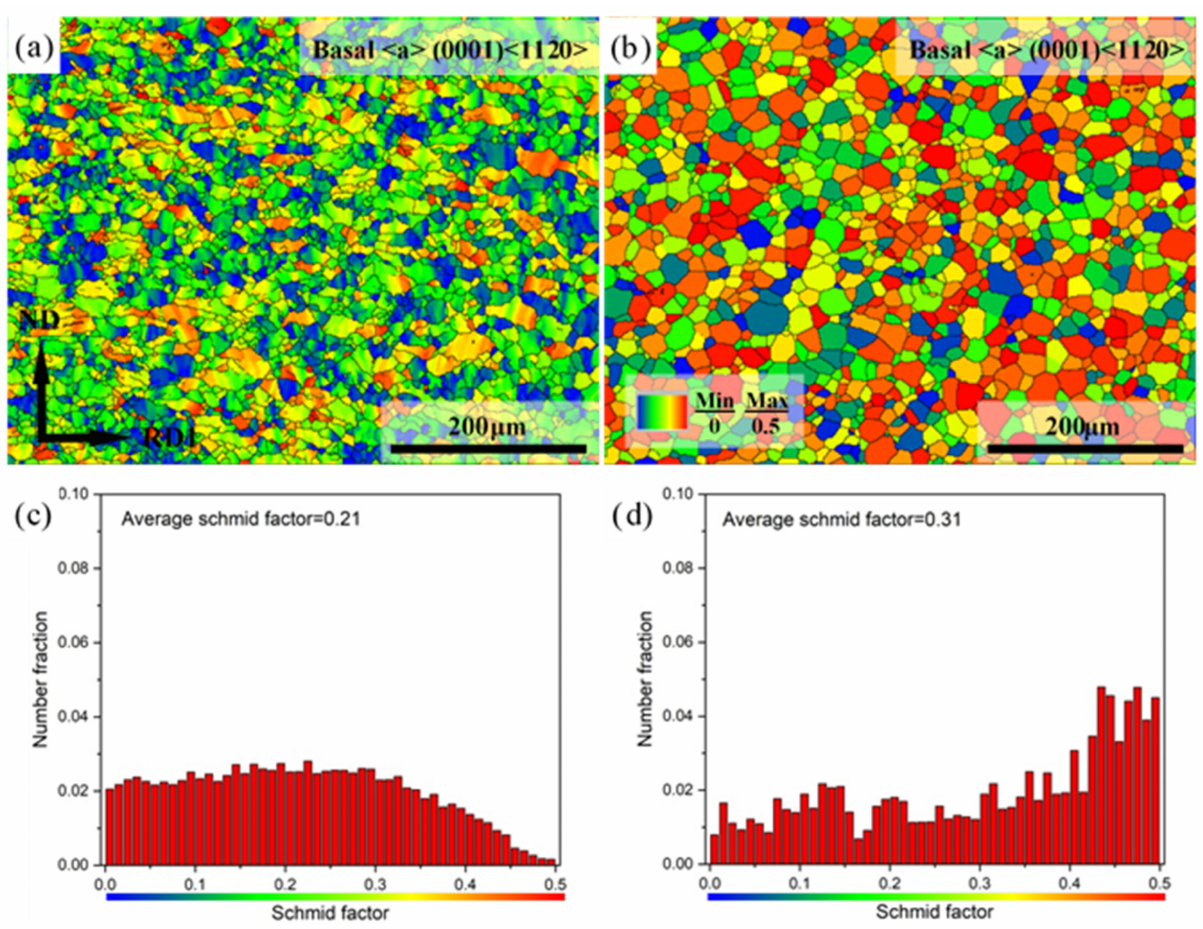
Figure 17. Basal <a> slip SF maps of ( a ) as-rolled, ( b ) as-annealed, and corresponding SF distributions of ( c ) as-rolled and ( d ) as-annealed Mg-3Y